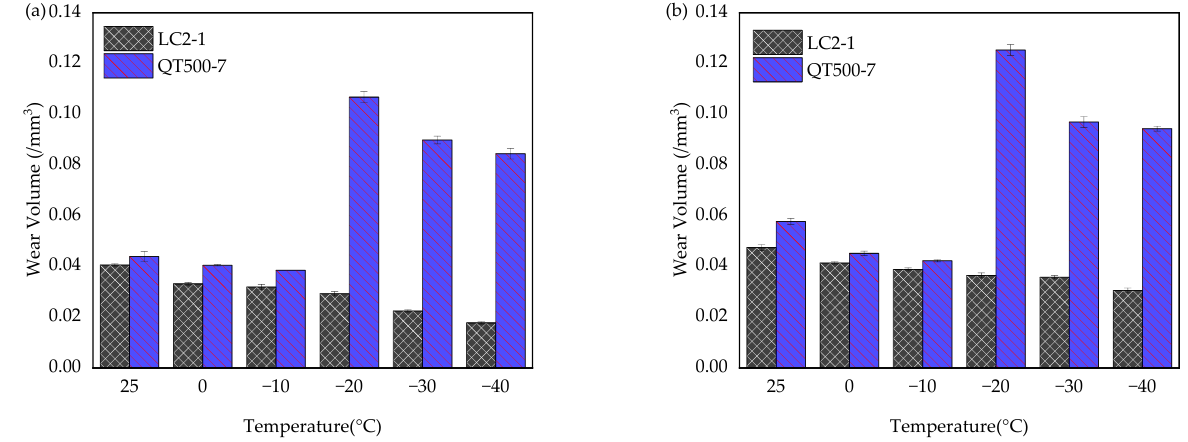
Figure 8. The wear volumes of LC2-1 and QT500-7. ( a ) The wear volumes of LC2-1 and QT500-7 at 20 N. ( b ) The wear volumes of LC2-1 and QT500-7 at 30 N. The wear volume of LC2-1 is decreased from 0.046 to 0.018 mm 3 or a 60% reduction